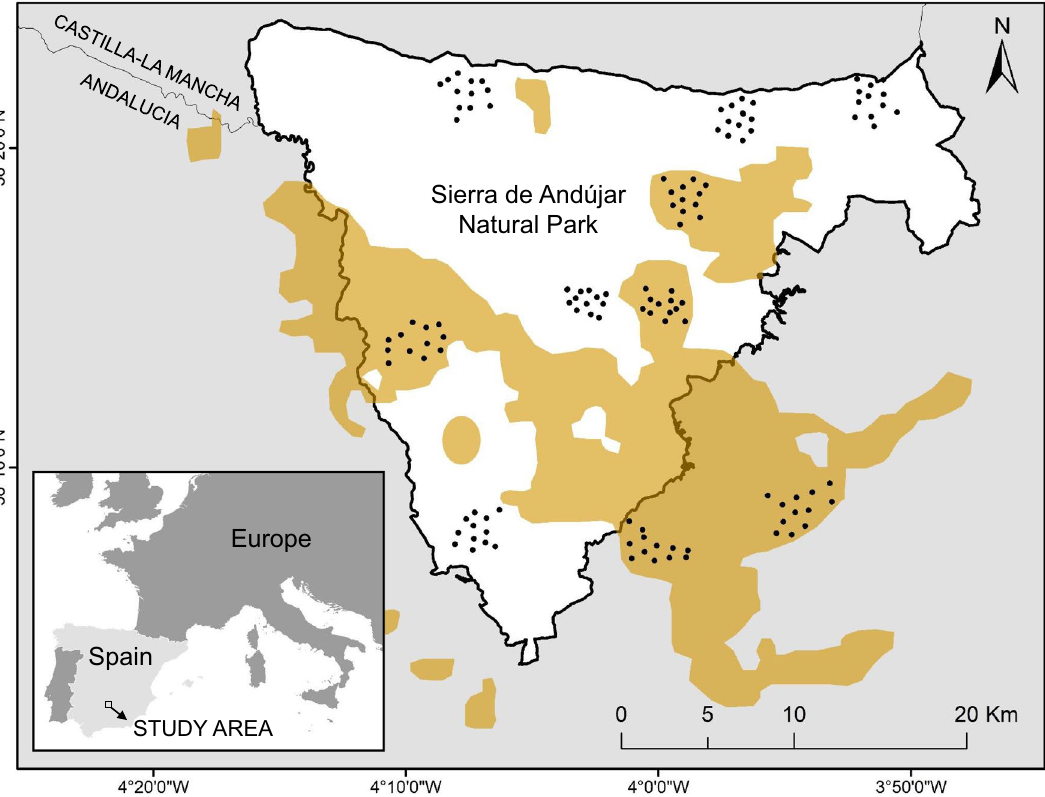
Figure 1. Map of study area showing the camera-trap sites (black dots) distributed in ten localities along the Sierra de Andújar NP and the Iberian lynx range (orange shadowed) adapted from the distribution map available in the IUCN Red List of Threatened Species 61 . Map was generated in ArcMap 10.6 https:// www. esri. com/.